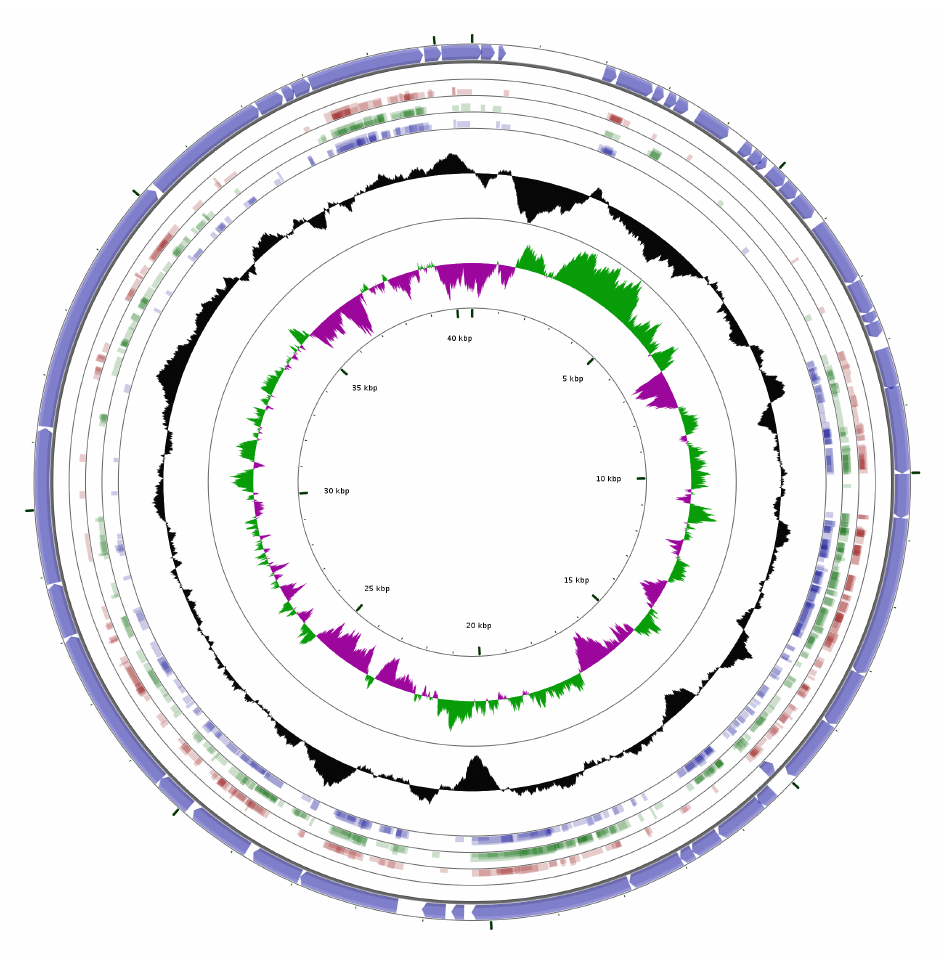
Figure 6. Alignment using tblastx (minimum E-value: 0.00001, minimum aligned query length: 10 amino acids, and minimum identity cutoff: 25%) of the Aquamicrobium phage P14 genome against the genomes of Pseudomonas phage Bf7 ( red ; NC_016764.1); Xylella phage Prado ( green ; NC_022987.1) and the Burkholderia phage Bp-AMP1 ( blue ; HG793132.1); The outer circle shows the coding sequences marked by arrows. The two inner circles show the GC content ( black ); and GC skew + ( green ) and the GC skew − ( magenta